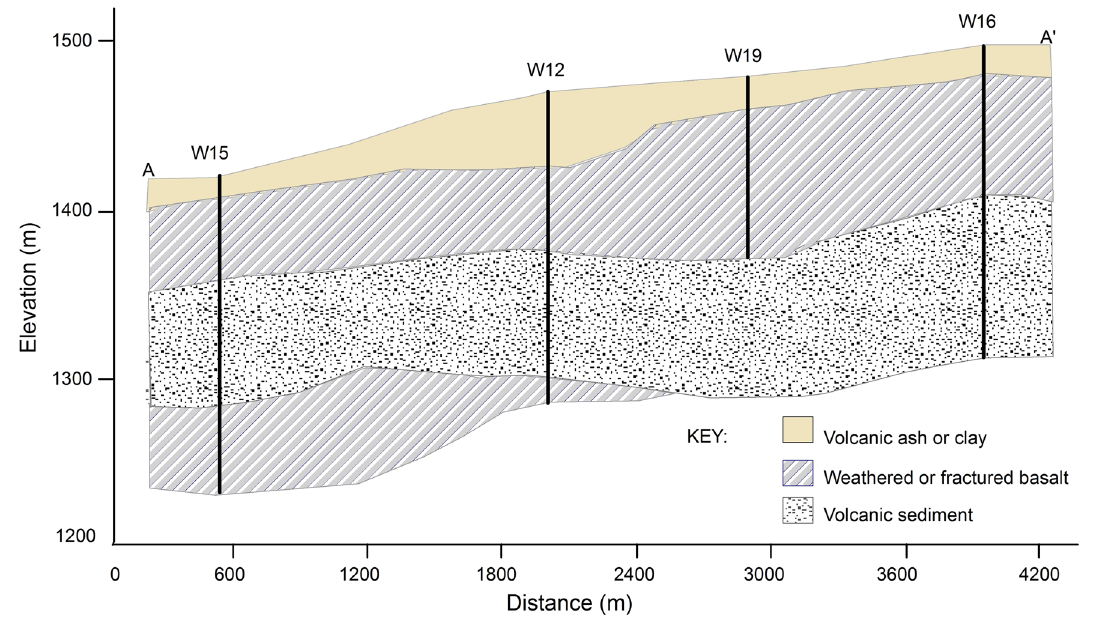
Fig. 4 Geological section A–A ′ derived from well logs in the study